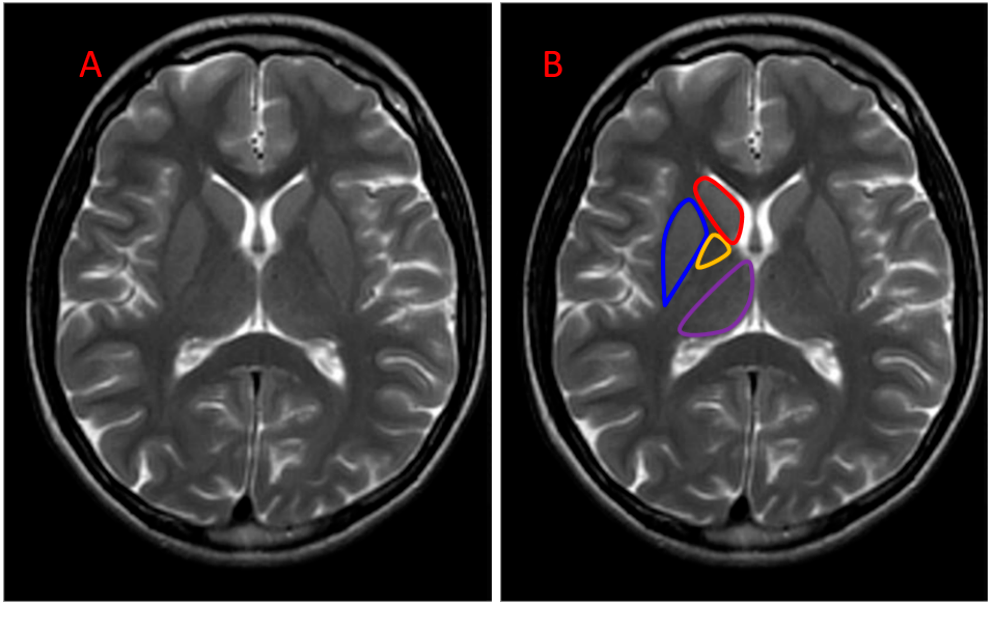
Figure 1. Brain anatomy on MRI, the basal ganglia on the T2-weighted image, axial plane ( A , B ). Due to subtle differences between the white and gray matter, magnetic resonance is the imaging method of choice because density changes on computed tomography (CT) scans are mostly unnoticed. Imaging of the basal ganglia in children is challenging due to infantile and childhood brain development and significant physiological changes in the appearance and signal of brain tissues.